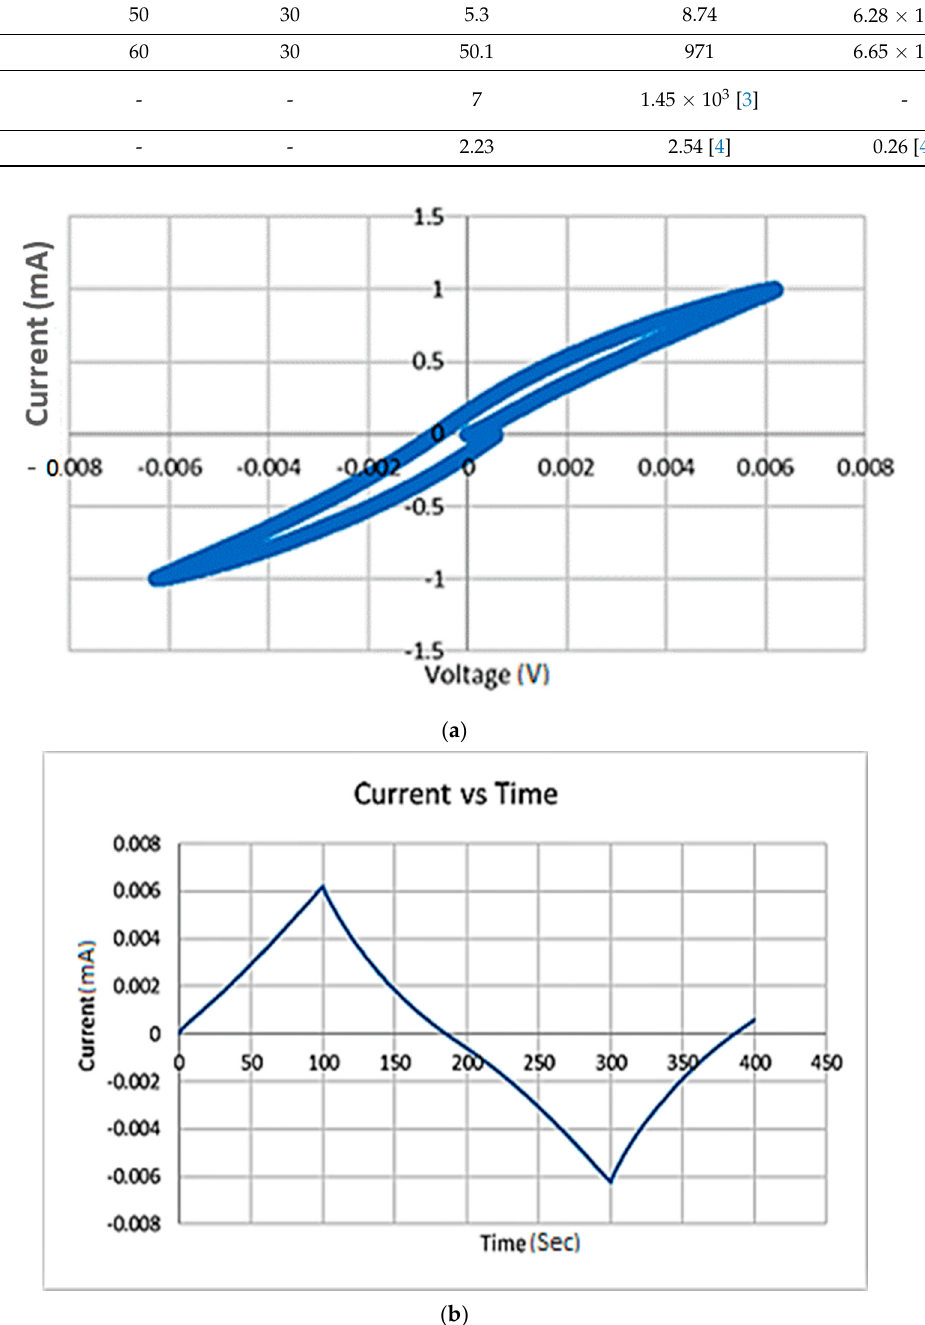
Figure 2. Nyquist plots for various samples: ( a – c ) shown are for samples 1, 2, and 3, respectively. For compositions, refer to Table 1.